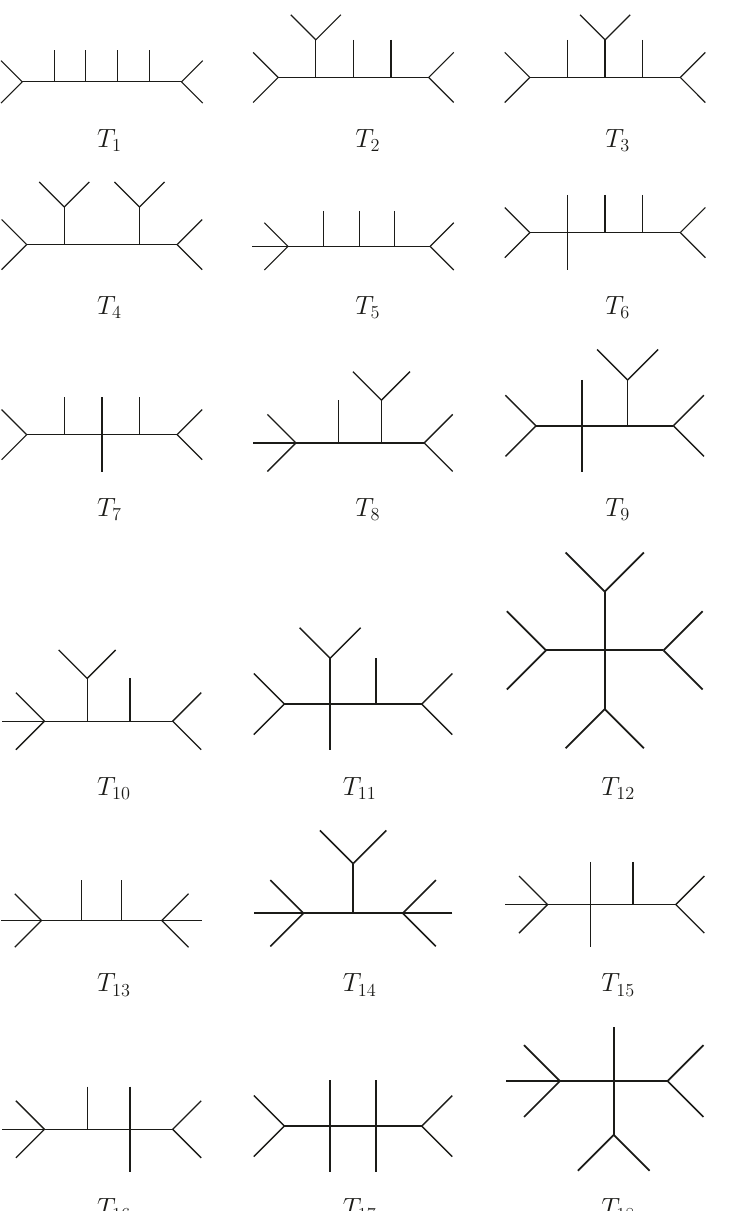
Figure 6 . The 18 topologies at d = 9 level that can give renormalizable